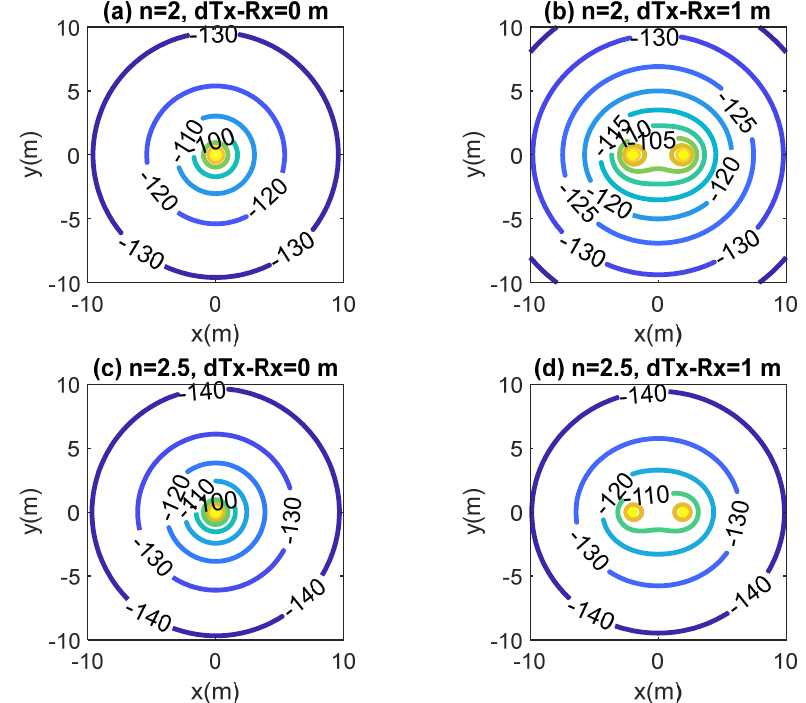
Figure 15. Simulated RSSI as a function of the location of the implanted backscatter assuming a depth of 5 cm inside the body for the monostatic case ( d Tx-Rx = 0 m) and bistatic case ( d Tx-Rx = 1 m). Path loss exponential factor n 1 = n 2 = 2 and n 1 = n 2 = 2.5.